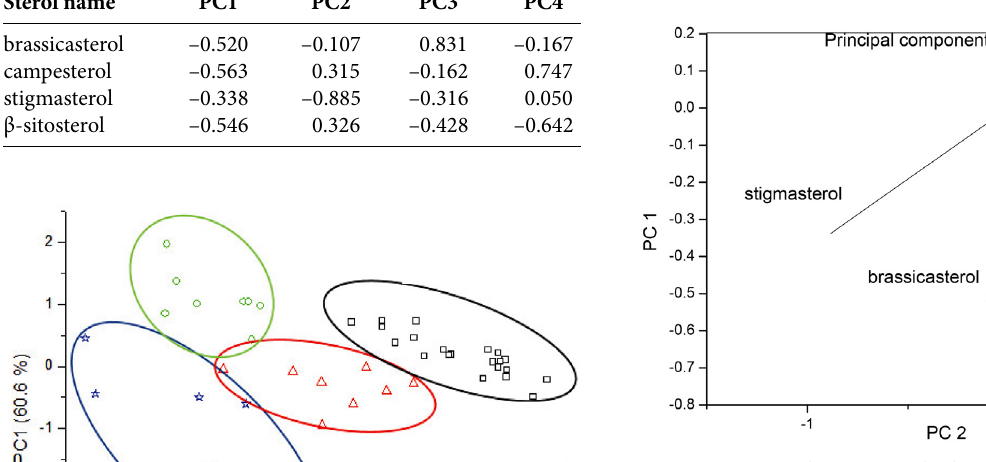
Figure 4. Principal components loading plot for PC1 and PC2 for the PCA model calculated based on sterol composition of 21 objects of camelina oil and 4 for mixtures of camelina with sunflower oil, 4 for mixtures of camelina with rapeseed oil and 4 for mixtures of camelina with soya